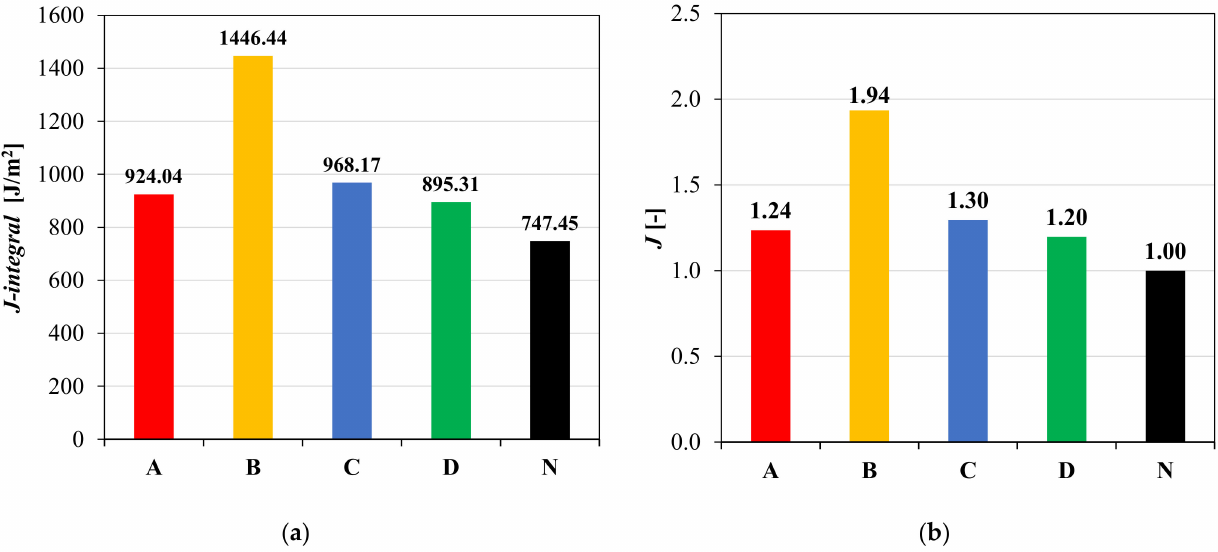
Figure 10. J-integral ( a ) and J ratio ( b ) values for different interface configurations from three-point bending